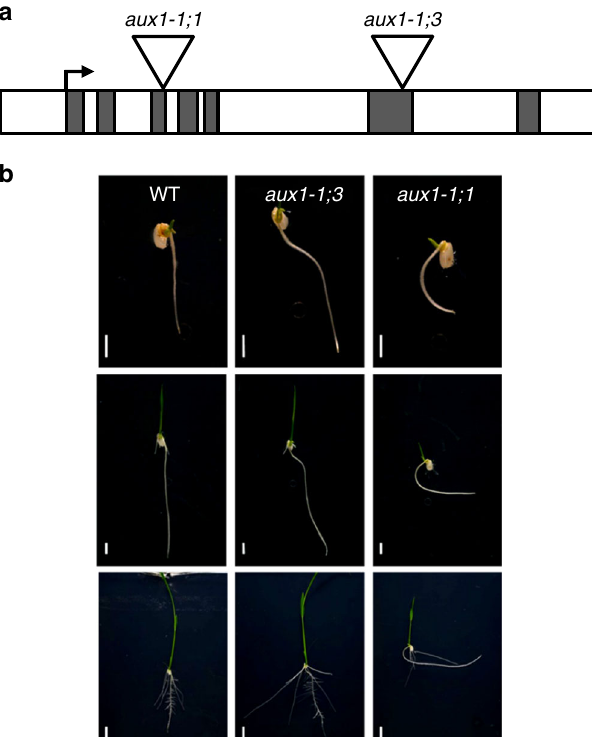
Fig. 1 OsAUX1 controls rice root angle. a Schematic representation of T- DNA insertion sites in Os AUX1 gene. b Time course images of root angle in WT, os aux1-1;1 and osaux1-1;3 T-DNA mutants. Images were taken after 3 days after seed germination (3DAG) to 8 days post germination (8DAG). White bars represent 0.5